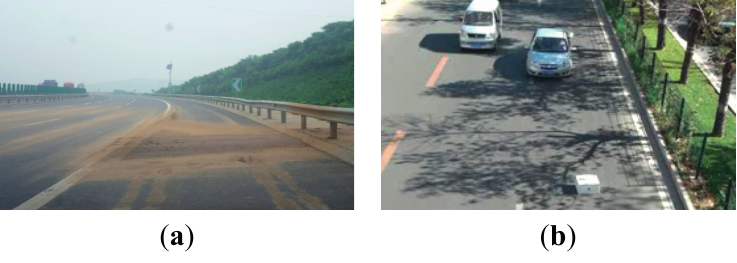
Figure 1. General abandoned objects in road traffic. ( a ) Harmless abandoned object; and ( b ) Hazardous abandoned